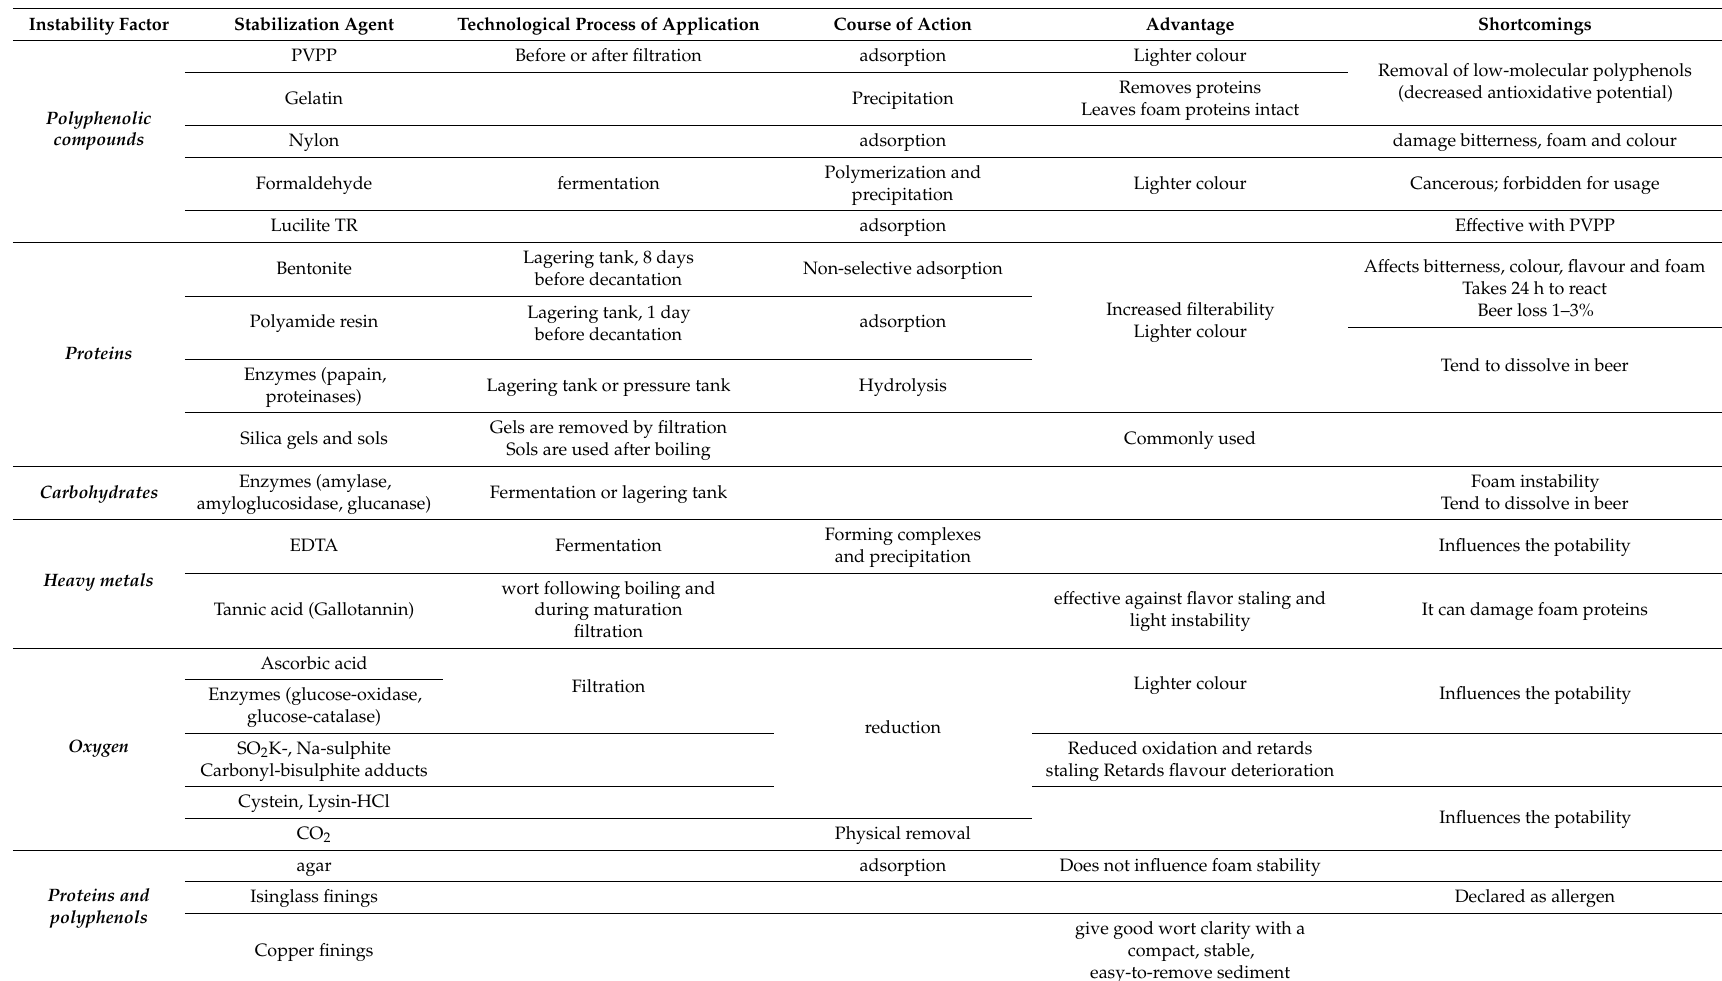
Table 1. An overview of haze causes and means to reduce